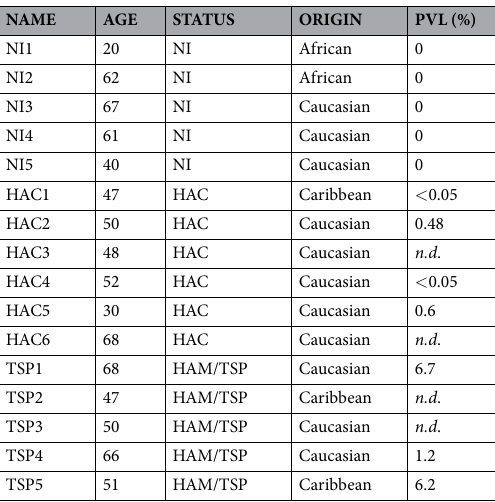
Table 1. Description of plasma donors. The 11 donors were female: 5 were non-infected (NI), 6 were HTLV-1 asymptomatic carriers (HAC), and 5 were HAM/TSP patients. The proviral load (PVL) was determined by